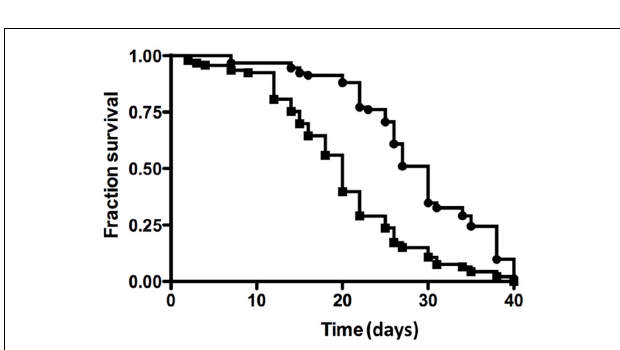
FIGURE 4 | Drosophila melanogaster survival assays for V. spinosum (squares) and PBS negative control (diamonds). Each experiment comprised 100 male wild-type Oregon R flies. Infected flies died faster than control flies according to log-rank analysis ( p < 0.0001).